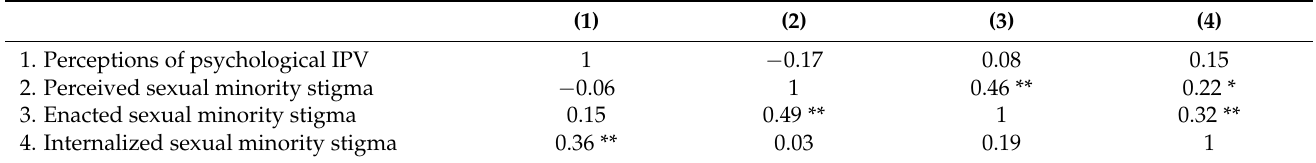
Table 3. Correlations between sexual minority stigma and perceptions of psychological intimate partner